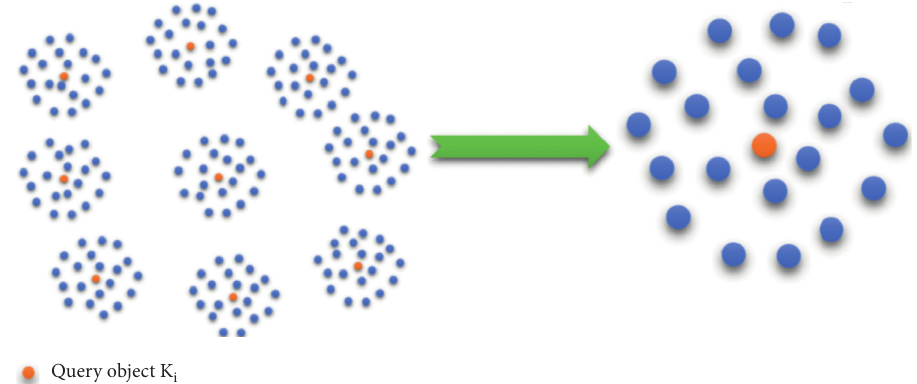
Figure 3: Map of average density ρ neighborhood